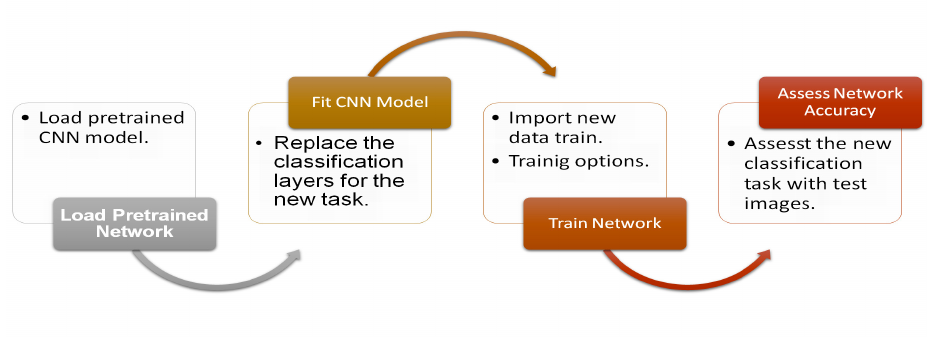
Figure 3. Simplified diagram of the learning transfer process.